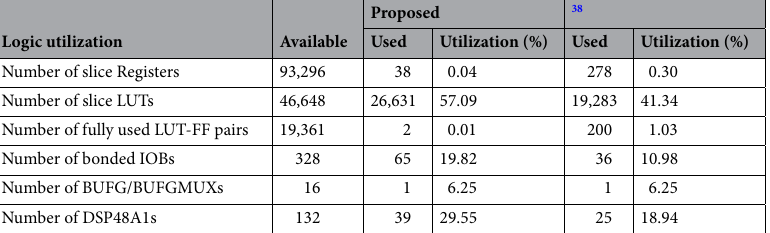
Table 3. Resource consumption rate of the proposed pseudo chaotic number generator for the FPGA board (Spartan- xc6slx75-2-csg484).